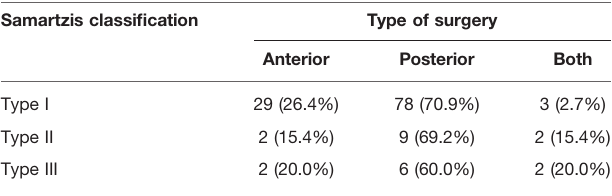
TABLE 4 | The distribution of the type of surgery.